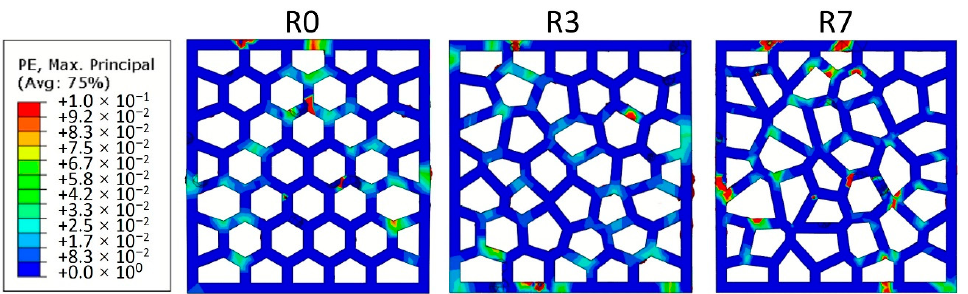
Figure 27. Simulated damage pattern of the LCCCs, plastic strain is indicated.